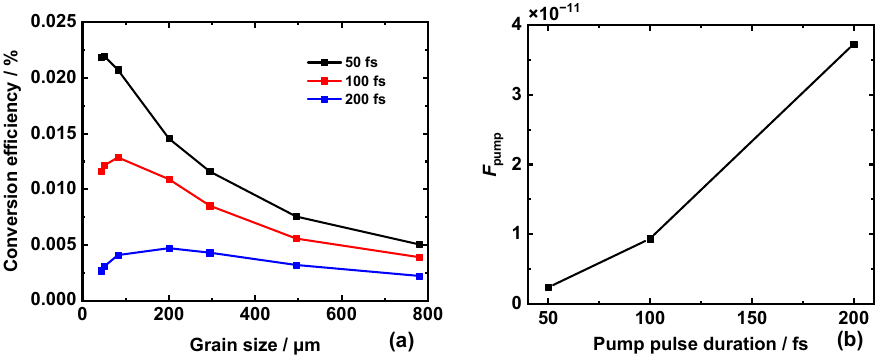
Figure 10. The conversion efficiency of RQPM OR versus ZnSe grain size ( a ) pumped at different pulse durations, with the pump fluence at different pulse durations ( b ) given as a reference.